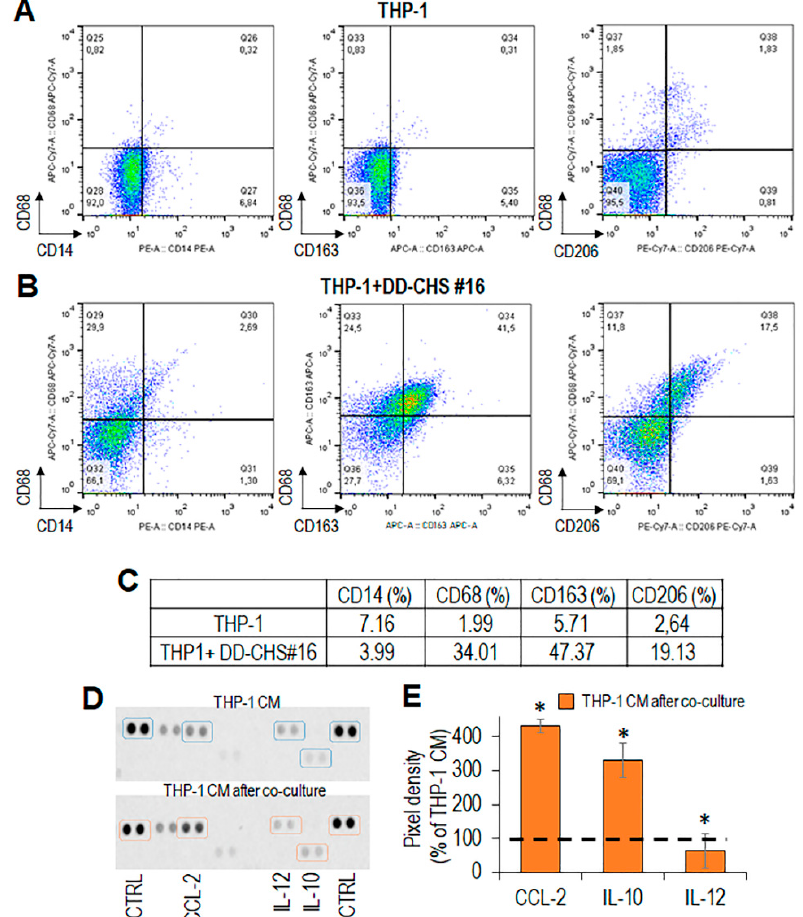
Figure 5. Immunophenotyping of THP-1 cells co-cultured with CHS cells. THP-1 cells were co-cultured with primary CHS cells for 72 h. ( A , B ). Phenotypic analysis of THP-1 cells, collected after co-culture, by flow cytometry. ( C ). Percent variation of CD14 + , CD68 + , CD163 + , and CD206 + cells upon co-culture with CHS cells, compared to control (THP-1 alone). ( D ). After co-culture, CHS cells were removed, THP-1 conditioned media prepared as described and analyzed for the content of CC2, IL-10 and IL-12 by a dot plot assay. ( E ). The pixel density of each spot was measured using NIH Image J 2.0 software. Positive control spots were used to normalize results between the membranes. The intensity of each spot was averaged over the duplicate spots and expressed as percentage of each cytokine or chemokine spontaneously secreted by THP-1 cells, considered as 100% (dashed line). Data represent mean ± SD from three experiments performed in quadruplicate with * p < 0.005.